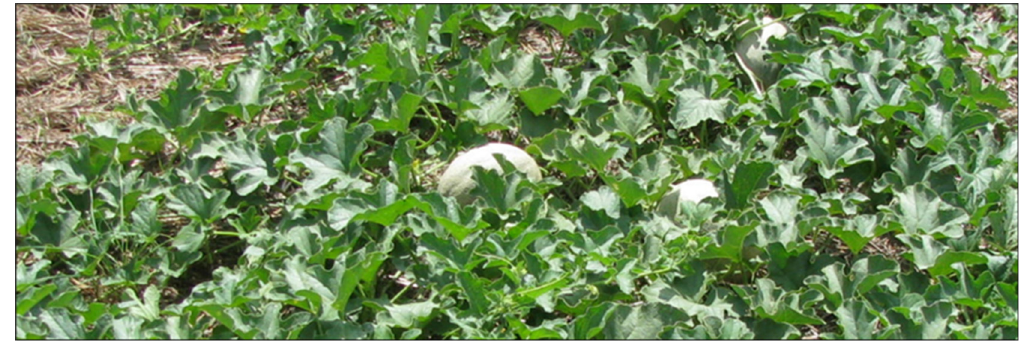
Figure 8. Cantaloupe fruits (Var: Athena) on cereal rye cover crop residue in 2010.